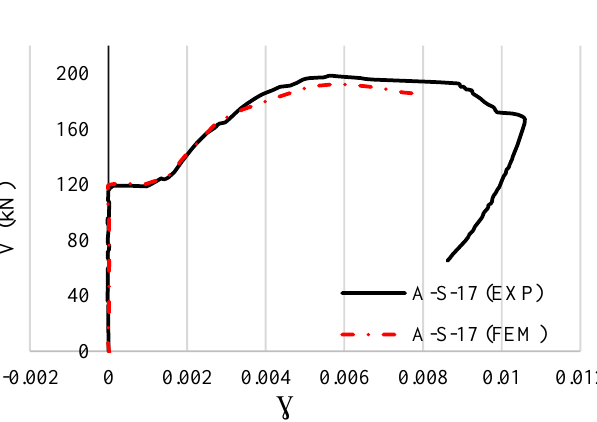
Figure 7. Comparison of the shear force-shear deformation curves of the reference beam (A-S-17) obtained from numerical analysis and the experiment [37].